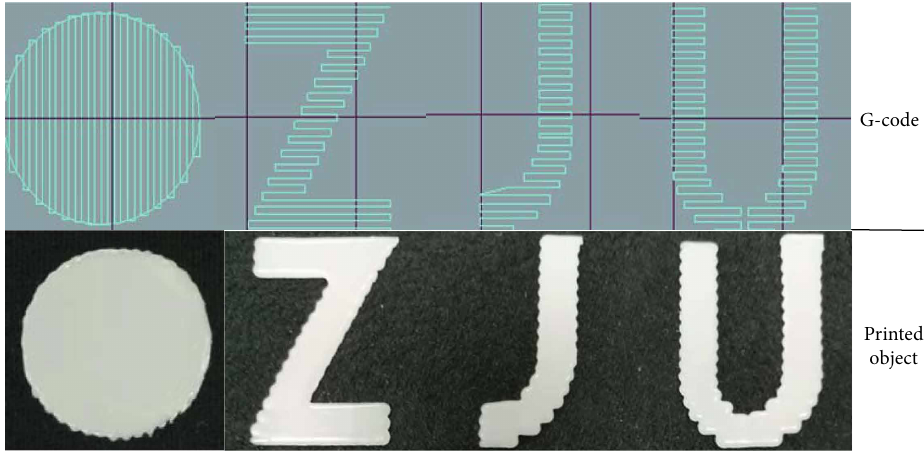
Figure 7: Other products with their appearance in